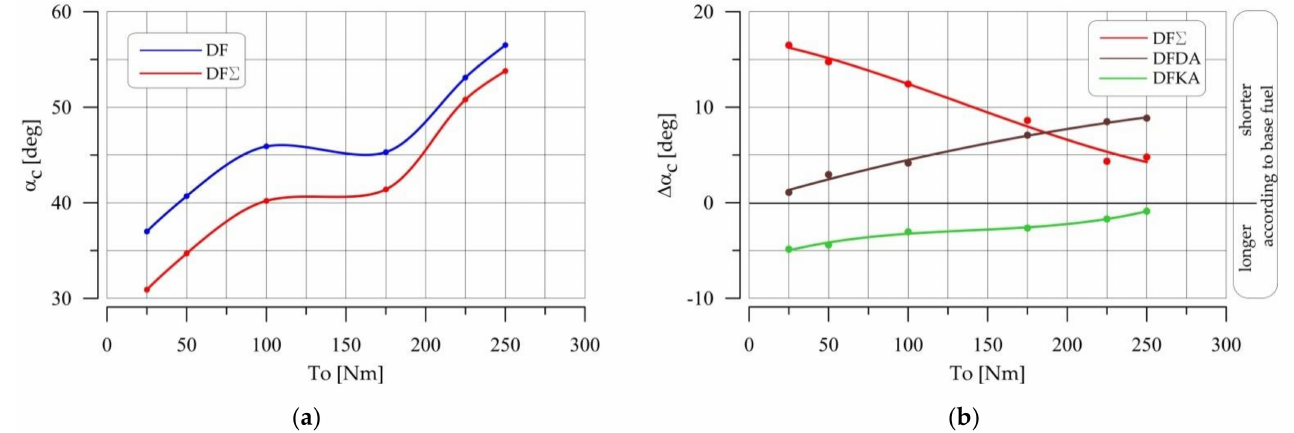
Figure 28. ( a ) Duration of combustion vs. engine torque; ( b ) Difference in combustion duration vs. engine torque in relation to the base fuel.